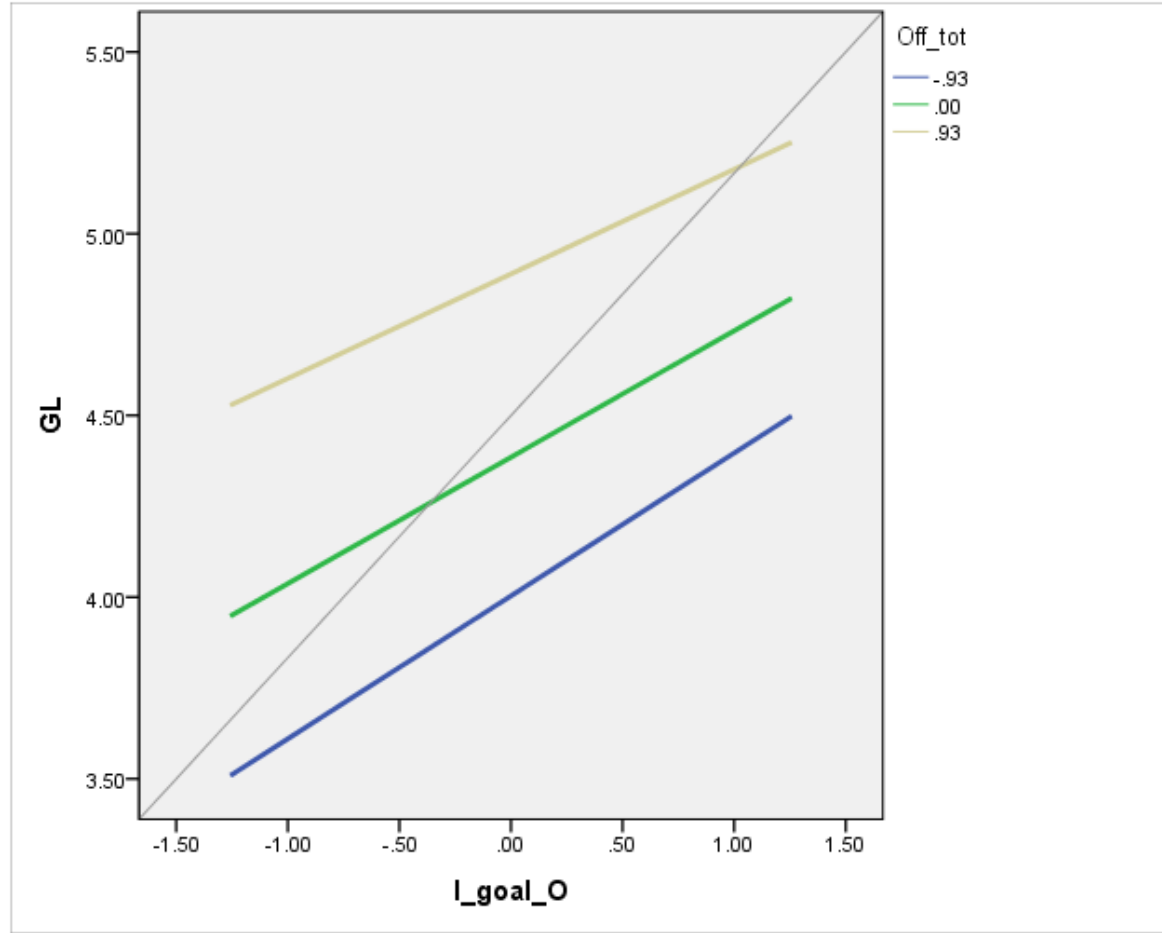
Figure 2. The relationships between intrinsic goal orientation and germane load by group work